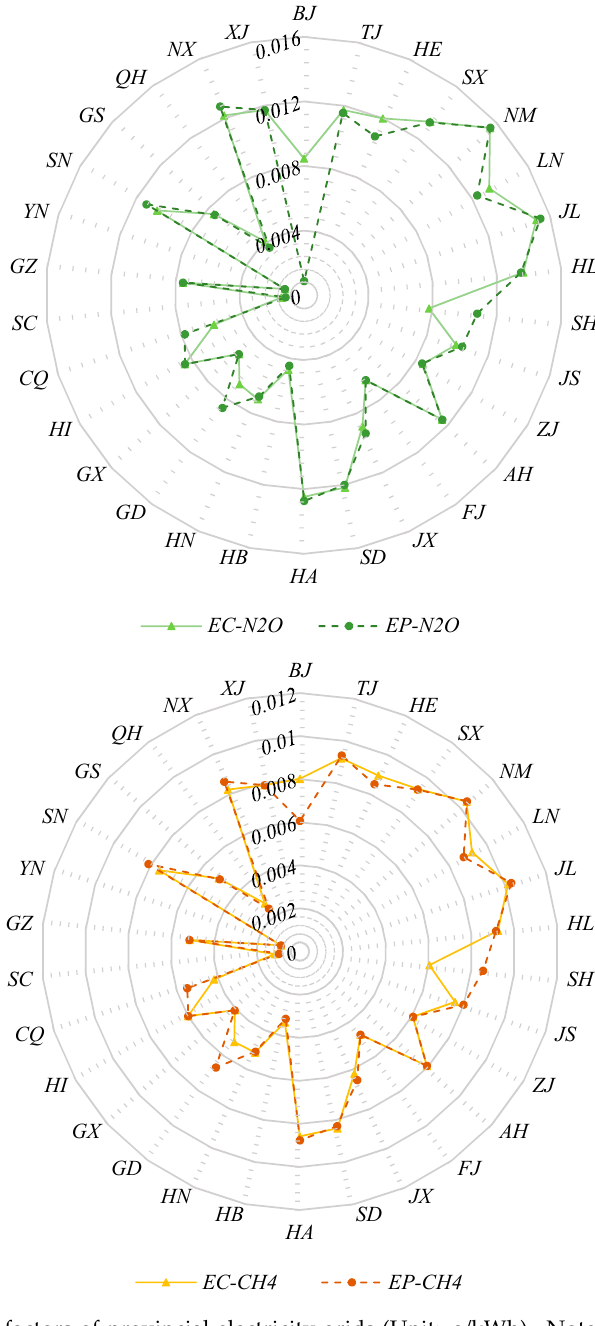
Figure 2. Emission factors of provincial electricity grids (Unit: g / kWh). Note: EC and EP denote emission factors of electricity consumption and generation, respectively.